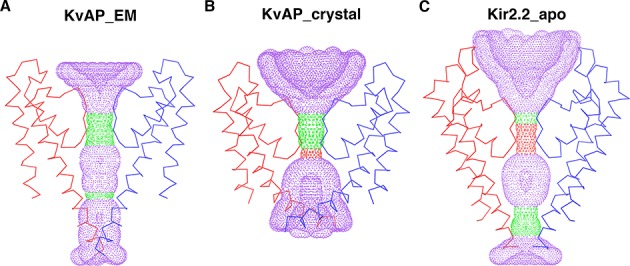
The central conduction pore of the cryo-EM structure of (A) KvAP (KvAP_EM), (B) the crystal structure of KvAP (KvAP_crystal, PDB: 1ORQ), and (C) the Kir2.2 apo crystal structure (Kir2.2_apo, PDB: 3JYC), generated with Hole (Smart et al., 1996).The channels are shown as Cα traces and only two opposing subunits (colored blue and red) are shown for clarity. The cytoplasmic region of Kir2.2 is omitted.